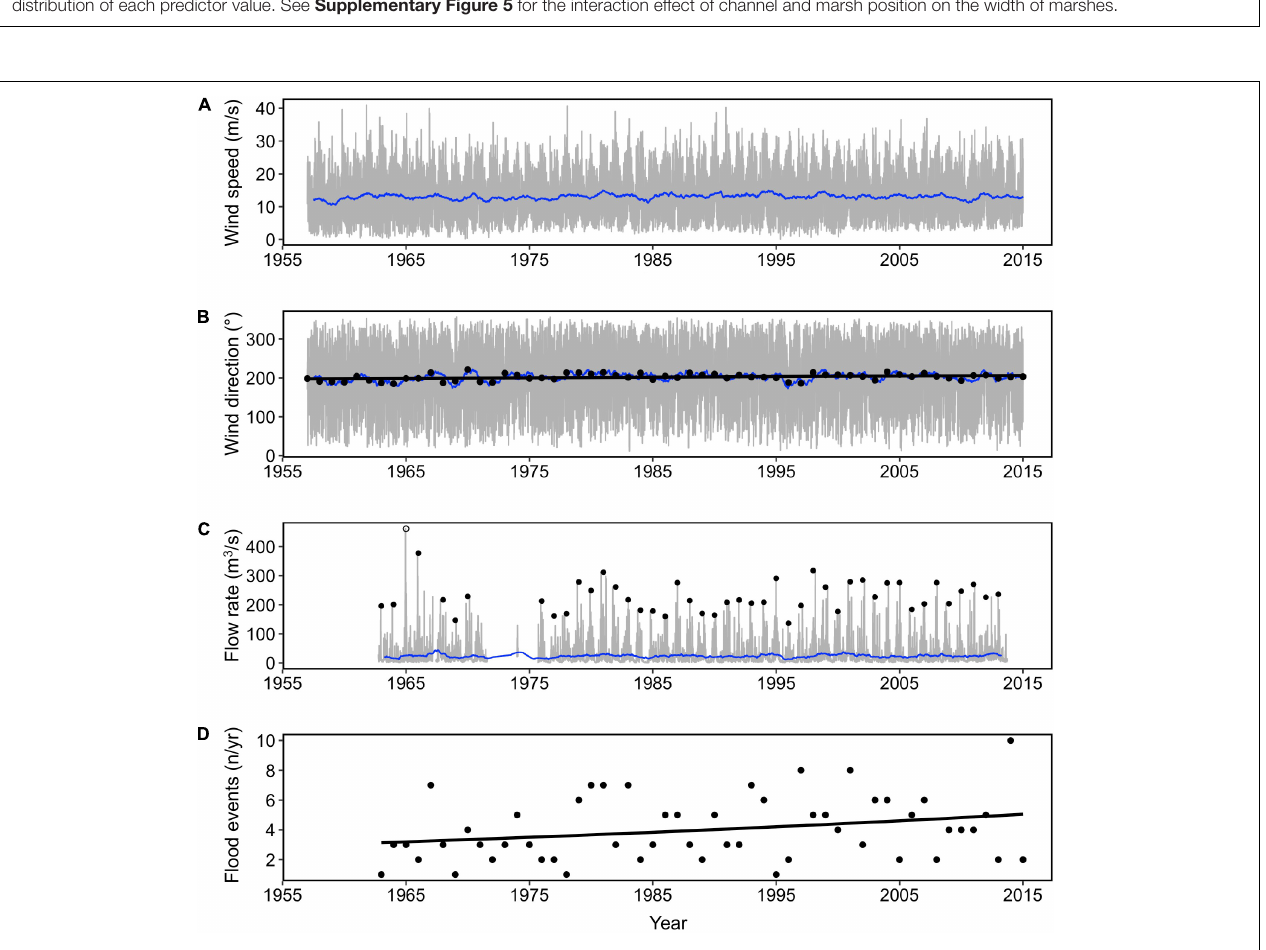
FIGURE 8 | (A) Daily average wind speed (gray line) with annual moving averages (blue line), (B) daily average wind direction (gray line) with annual moving averages (blue line), and annual average wind direction (black circle) for the period 1957–2017 (wind station, station ID 1198, 52 ◦ 8 (cid:48) 21 (cid:48)(cid:48) N, 4 ◦ 34 (cid:48) 12 (cid:48)(cid:48) W). (C) Daily average river flow rate (gray line) with annual moving average (blue line), maximum annual flood event per water year (black circle), and (D) number of flood events per year (black points) for the period 1957–2017 (river gage, ID 64001, 52 ◦ 36 (cid:48) 3 (cid:48)(cid:48) N, 3 ◦ 51 (cid:48) 17 (cid:48)(cid:48) W). Black lines indicate fitted values for parsimonious models. Hollow circle indicates a single outlier, which was not included in the model fit for (C)